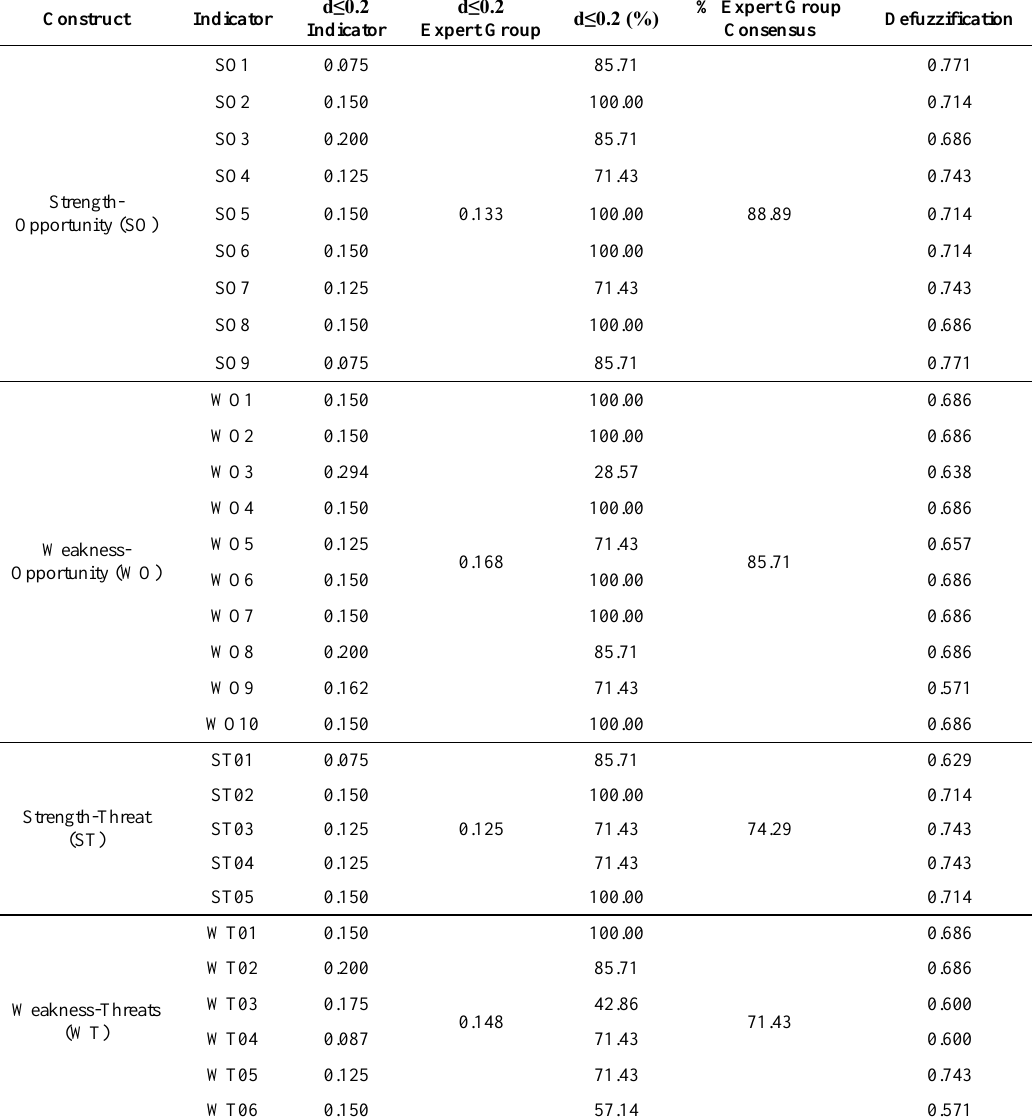
Table 10. Fuzzy Delphi Analysis for